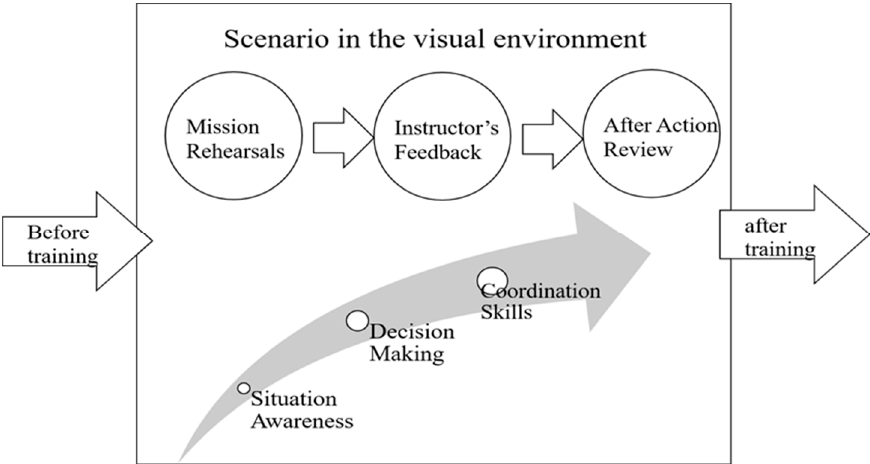
Figure 1. System training effectiveness process.